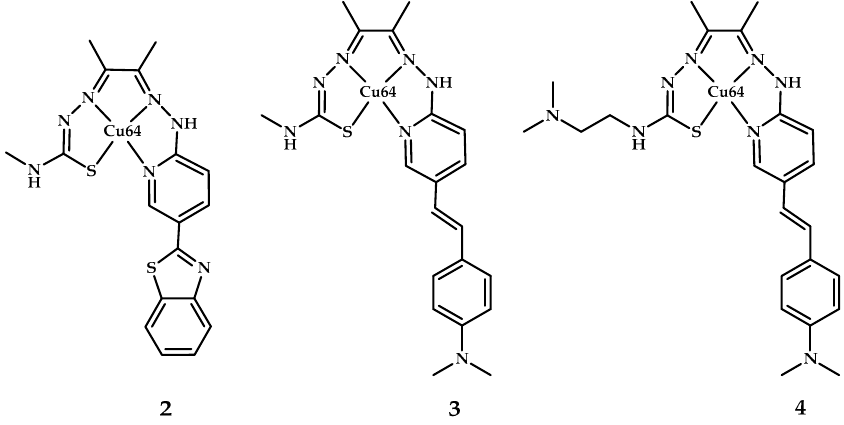
Figure 3. 64 Cu(II)–ATSM derivatives conjugated 2–4 with benzothiazole/styrylpyrydine functional Figure 3. 64 Cu(II)-ATSM derivatives conjugated 2 – 4 with benzothiazole / styrylpyrydine functional group, designed for A β fibrils visualization. group, designed for A β fibrils visualization.